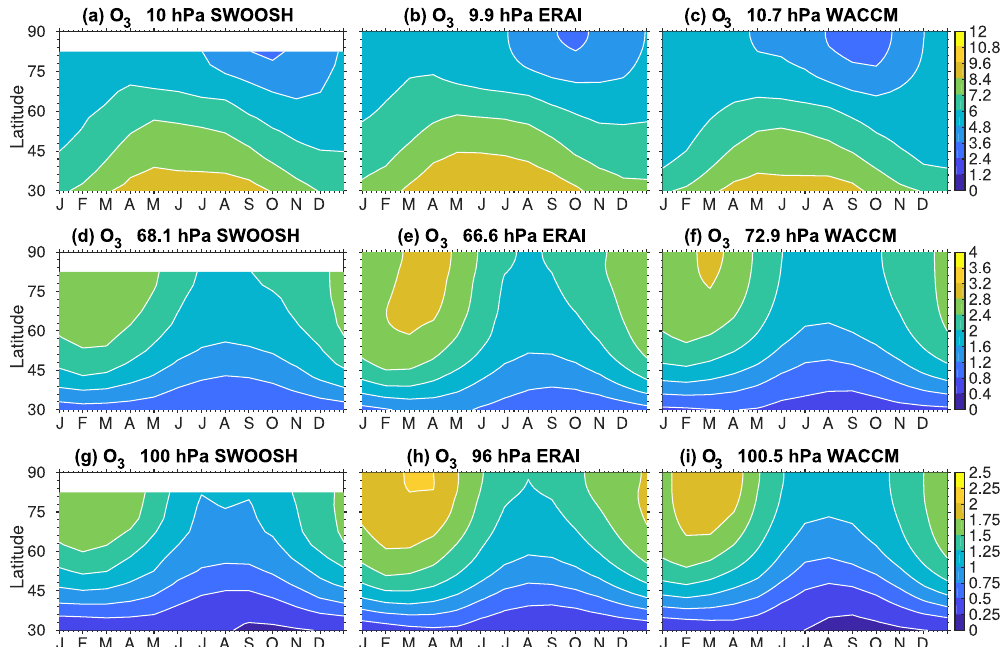
Figure 1. Climatological seasonal cycle of zonal-mean ozone (ppmv) north of 30 ◦ N at different pressure surfaces in the lower and mid- stratosphere for (a, d, g) SWOOSH data, (b, e, h) ERA-Interim, and (c, f, i) WACCM output.